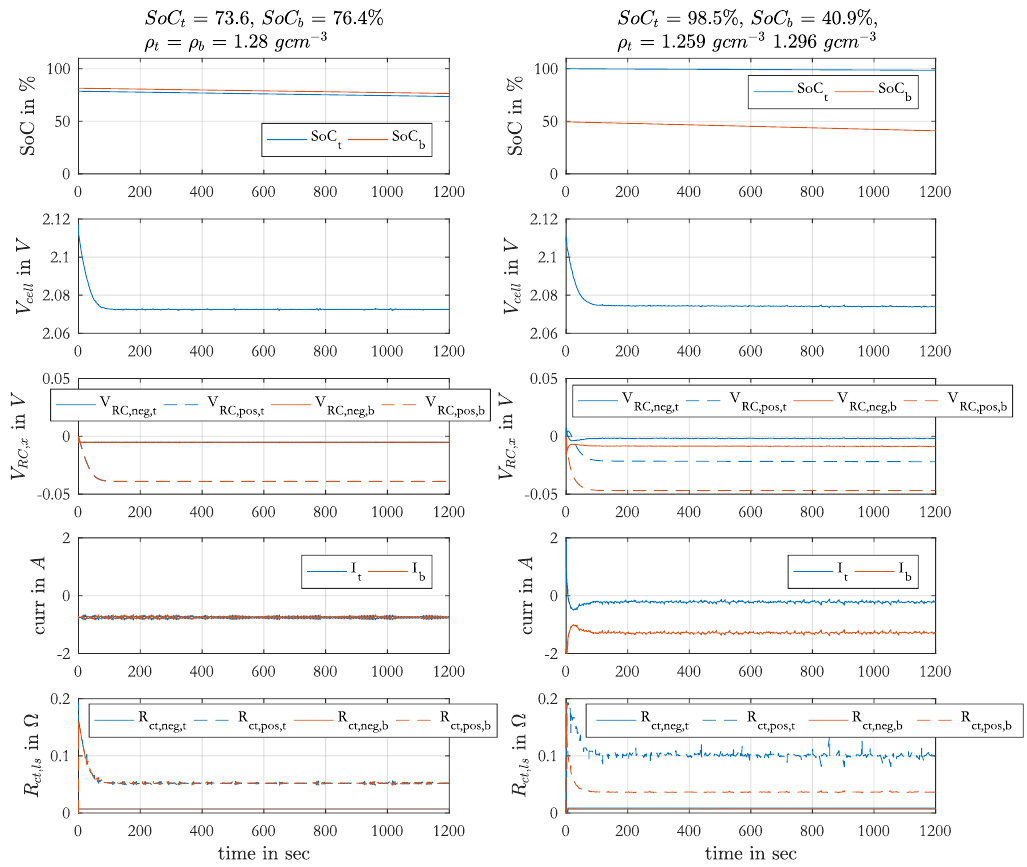
Figure 8. Simulated current distribution in the srEEC during discharging with − 3I 20 . SoC x , V cell , V RC , x , I x and the values for R ct , x are shown. On the left side the results from simulation with homogenous acid are presented, on the right side with stratification as during Strat. 1